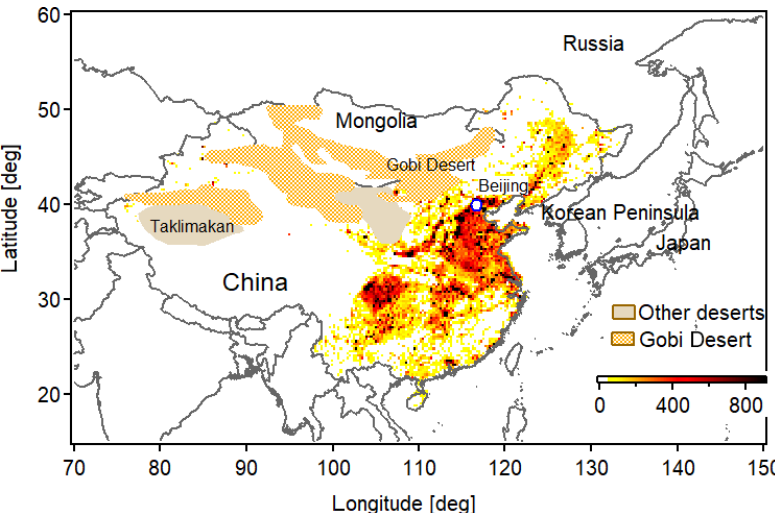
Figure 1. Geographical location of the observation site in Beijing, PM 2 . 5 emissions in China and the location of major deserts including the Gobi in East